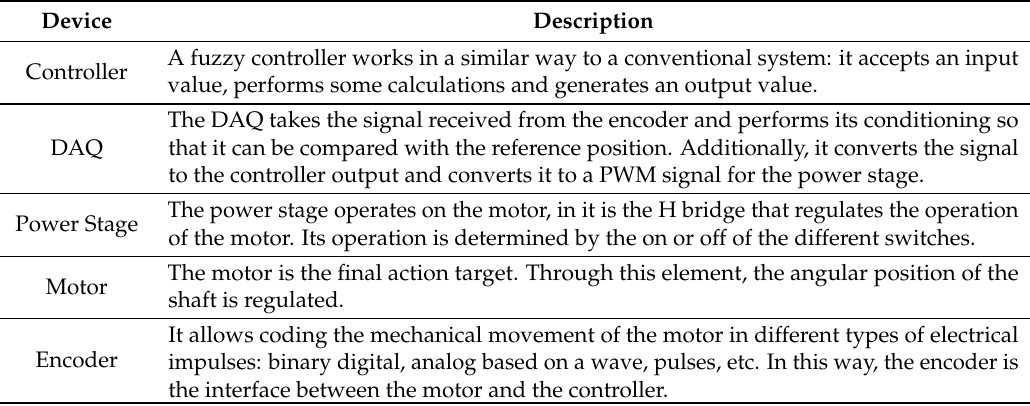
Table 2. Description of the function of each